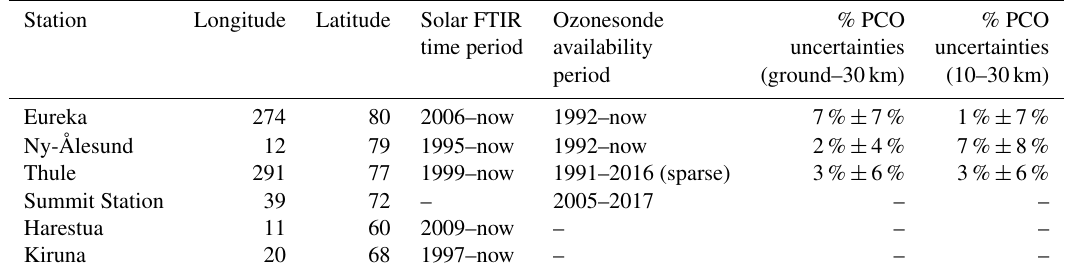
Table 1. Site locations for NDACC FTIRs and ozonesondes. Uncertainties of FTIRs at three sites with ozonesondes are given by averaged subtraction and standard deviation of ozonesondes from the retrieved ozone from FTIR, as uncertainty of partial column ozone (PCO) in both ground to 30km and 10 to